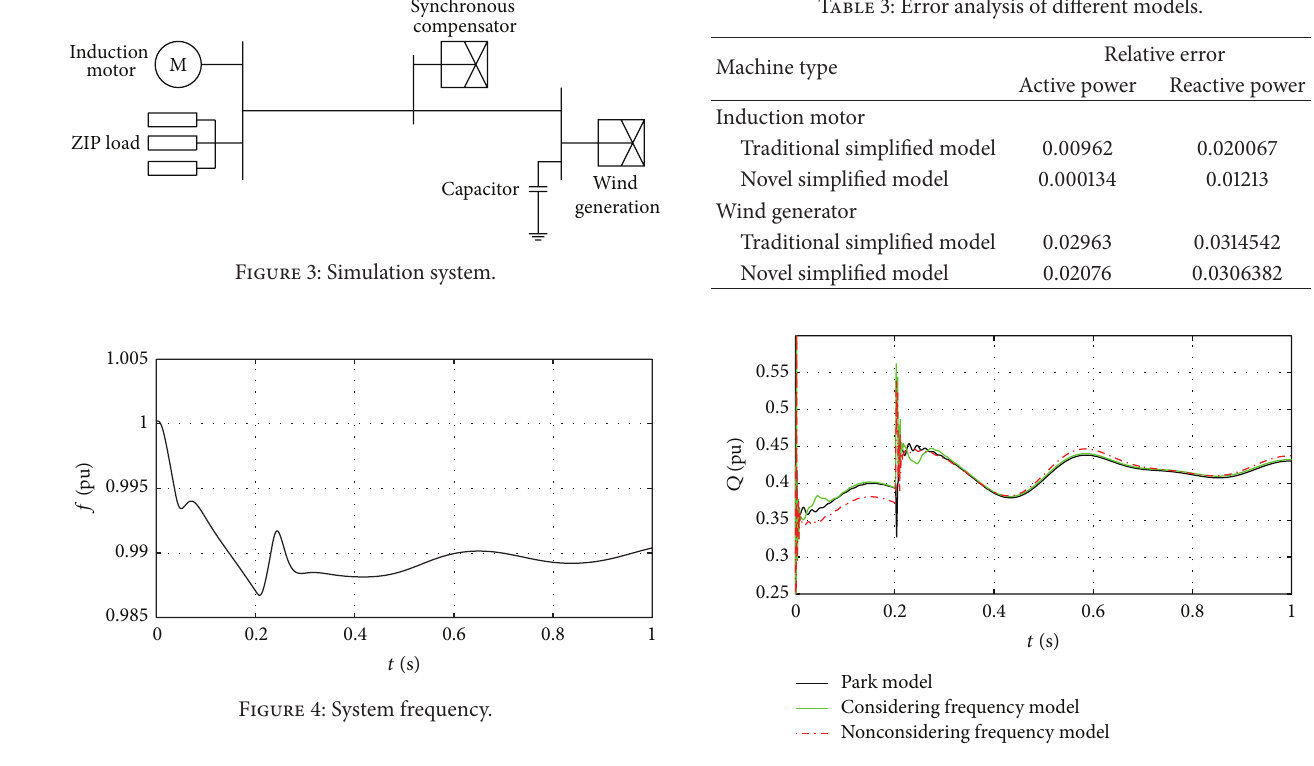
Figure 7: Reactive power of induction